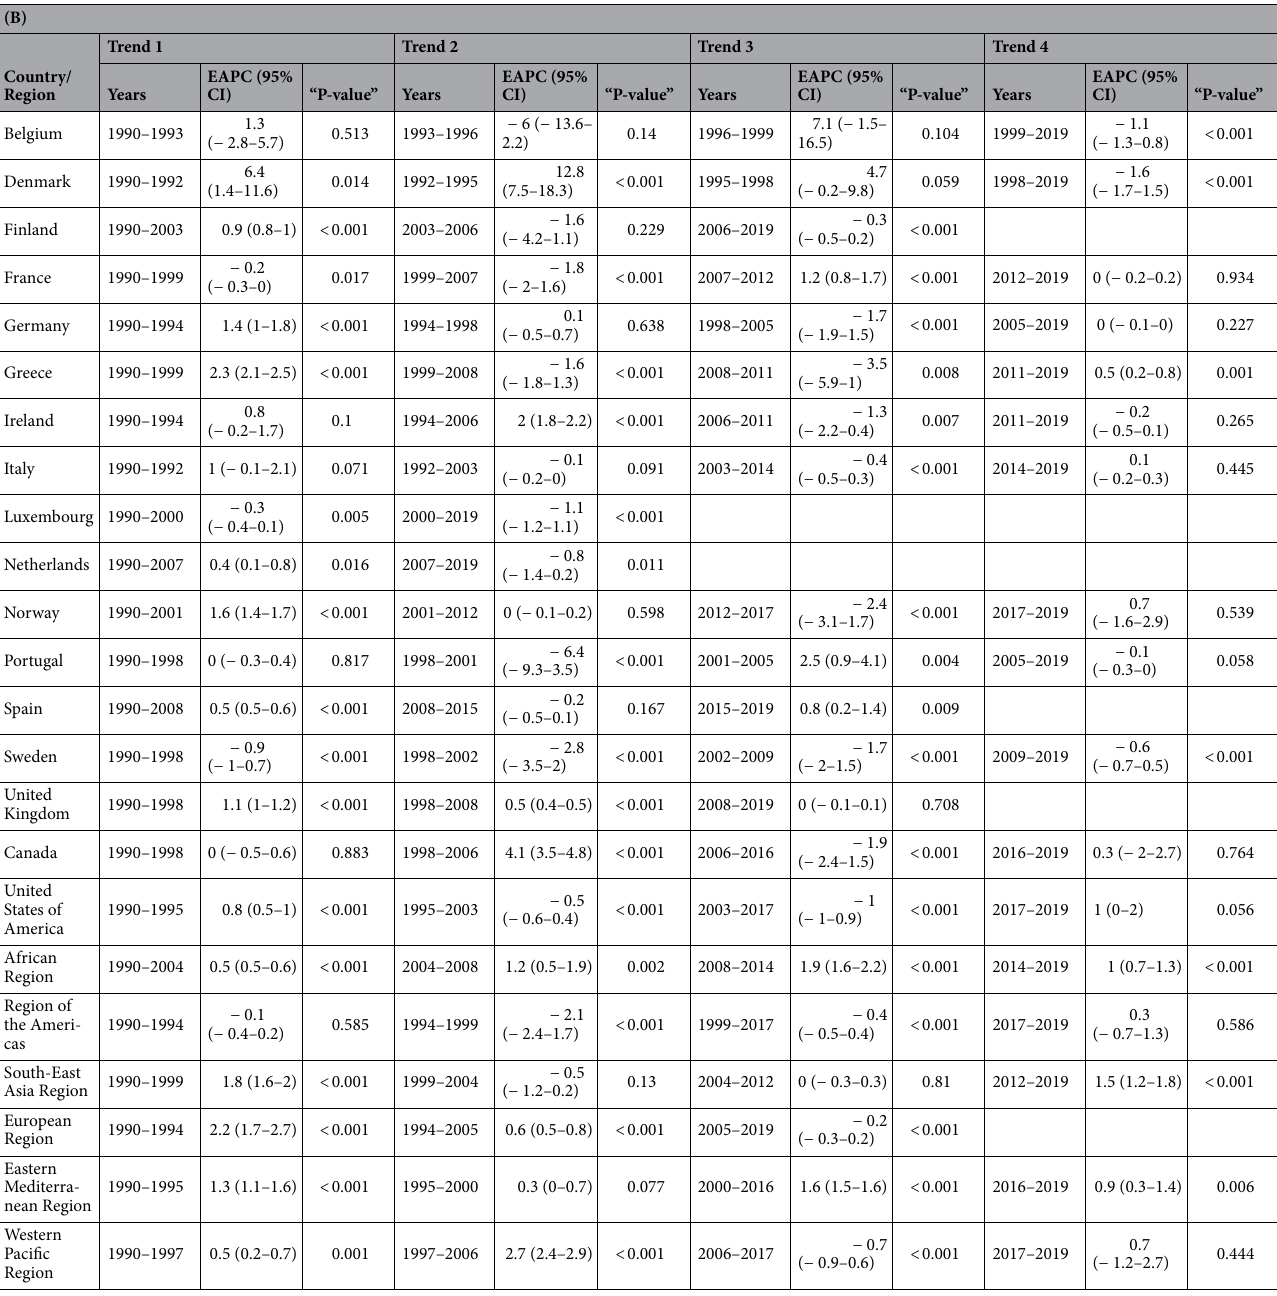
Table 4. Joinpoint analysis for KC age-standardized mortality rates in EU15 + countries and WHO regions for years 1990–2019 in males (A), females (B) and both sexes (C). EAPC indicates estimated annual percentage change, with 95% confidence intervals in brackets. *Significantly different from 0 (P < 0.05). AAPC (Average annual percentage change) indicates summary measure of the trend over